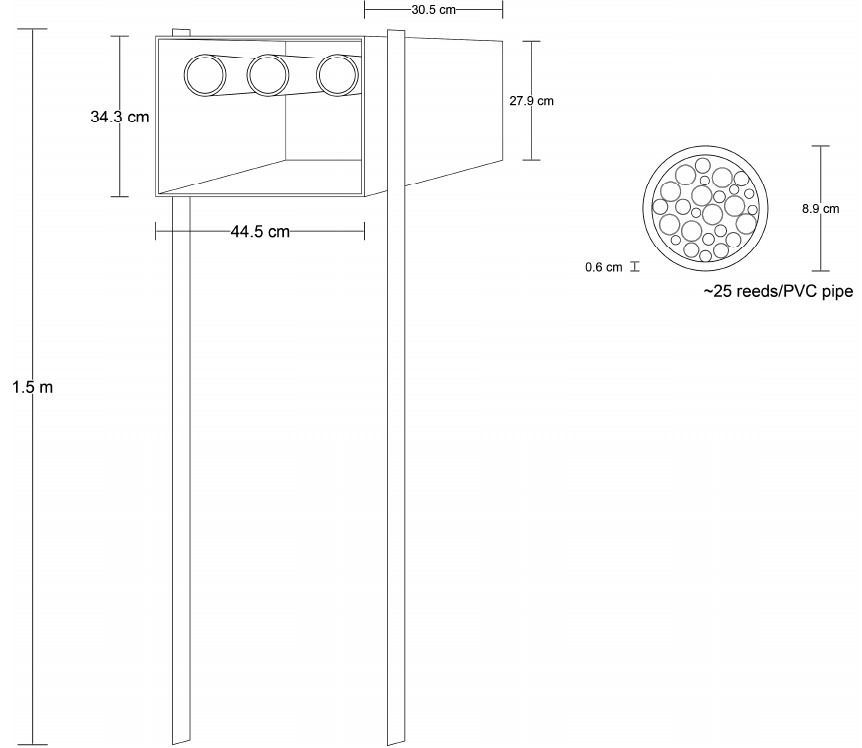
Figure 2. Drawing and measurements of the trap-nest used in this study to collect trap-nesting wasps and bees between August 2014 and November 2015.